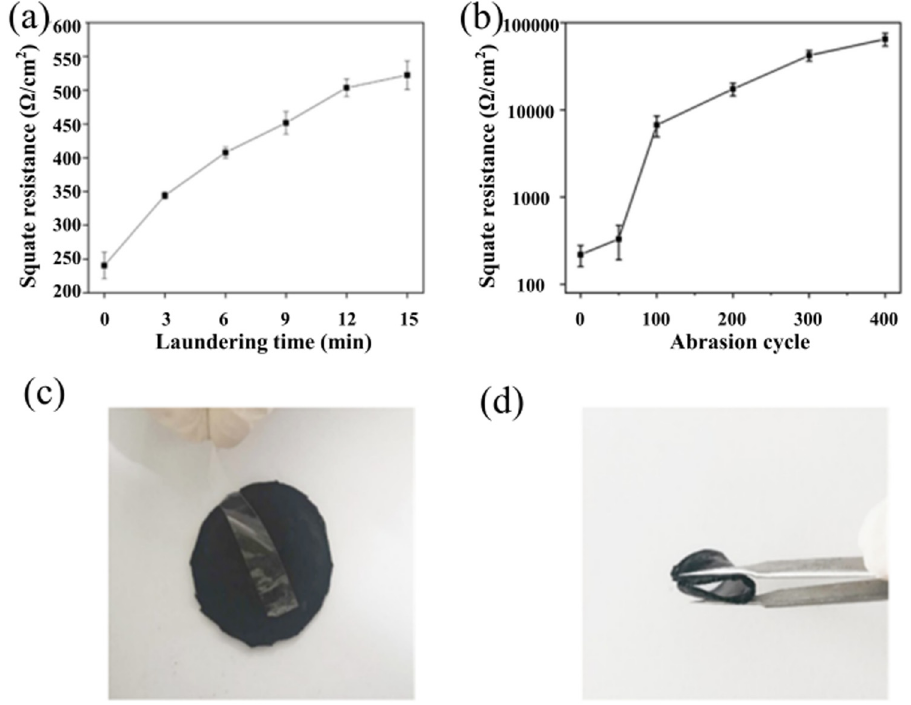
Figure 6: E ff ect of ( a ) laundering time and ( b ) abrasion cycles on the electrical conductivity of SF. ( c ) Adhesive and ( d ) fl exible display of optimum reaction time of SF/PEDOT